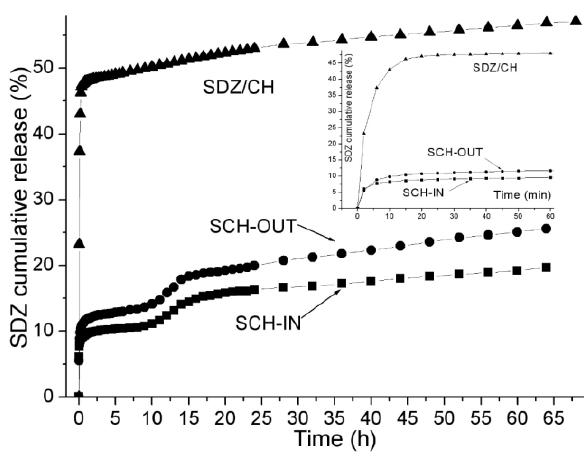
Figure 7. Cumulative sulfadiazine release ( M t / M ∞ ) profiles in phosphate buffer solution of pH 6 at 37 °C (where M t is the cumulative amount of drug released at time t and M ∞ is the maximum amount released at the plateau of the release curve).